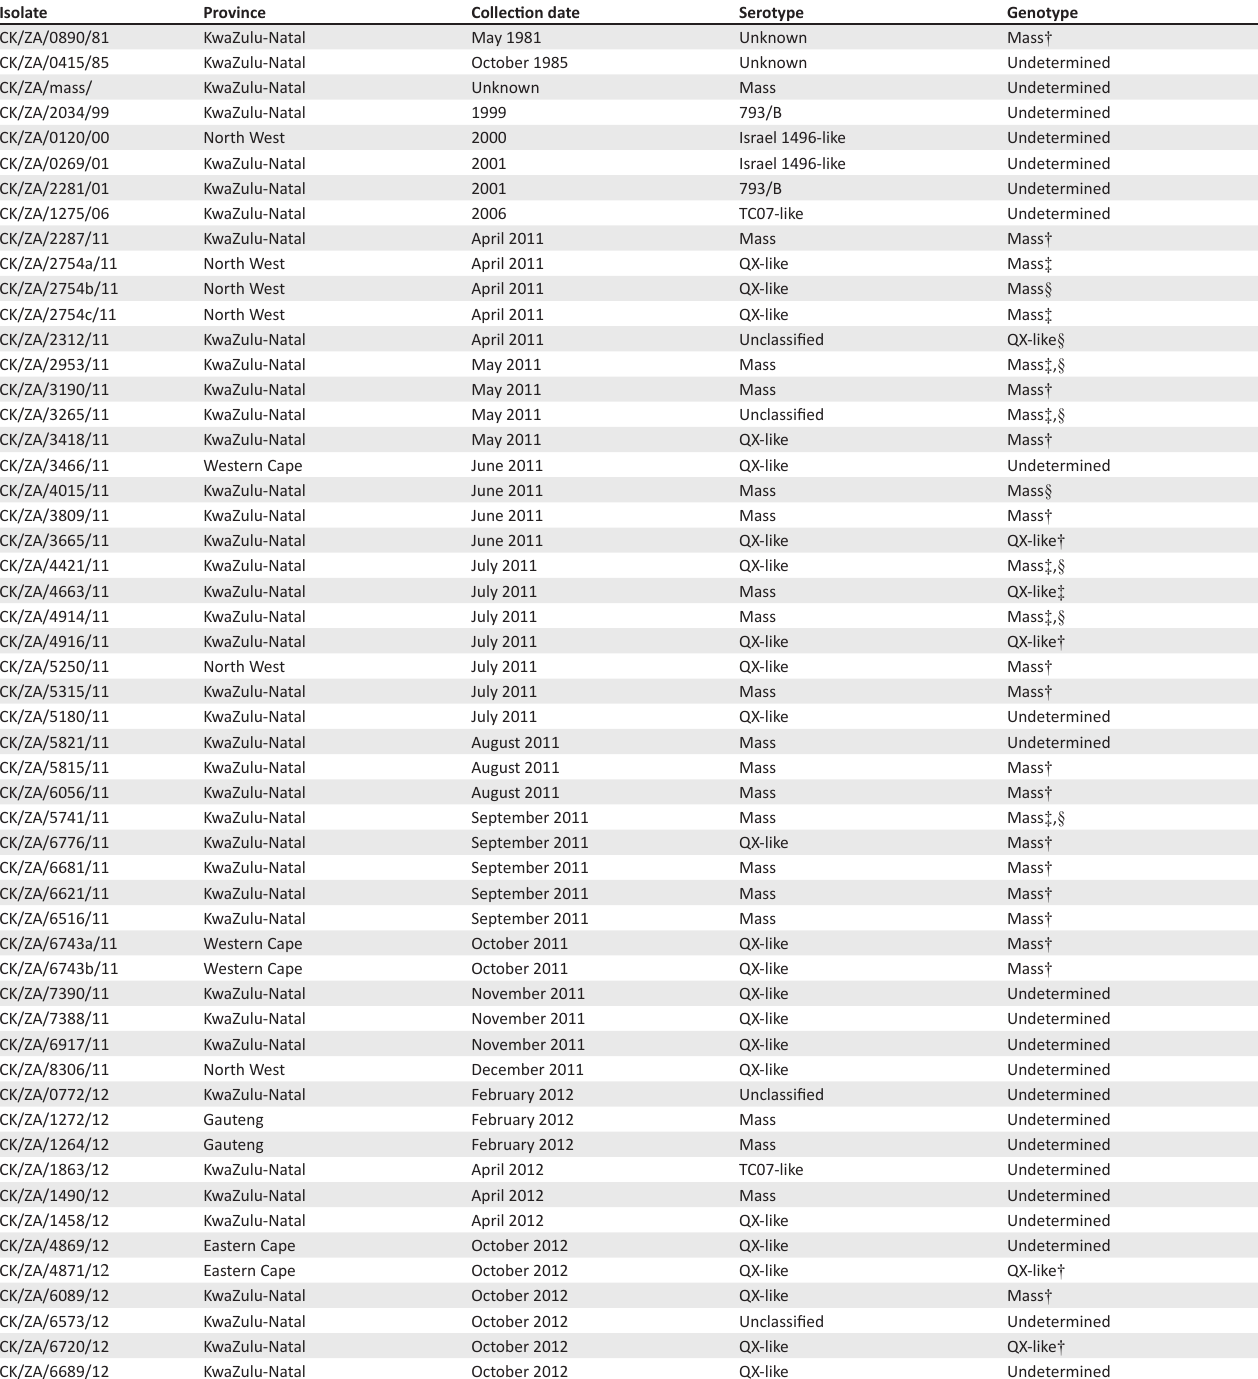
TABLE 1: Infectious bronchitis viruses characterised in this study.